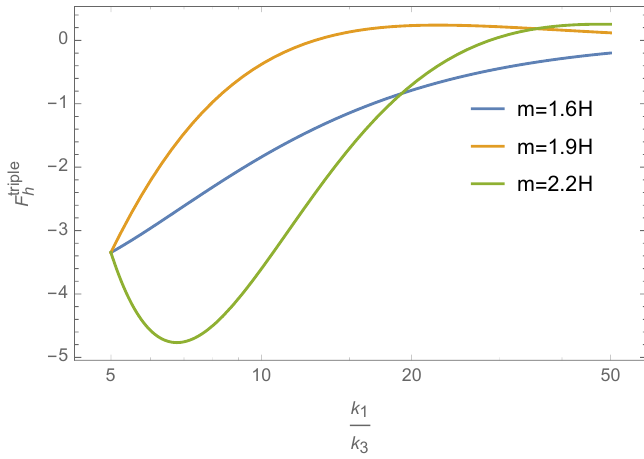
Figure 11 . Dimensionless three-point function F triple E(cid:11)ective description (B.35) with (cid:21) 2 = 0 : 2; (cid:21) h = 0 : 5.